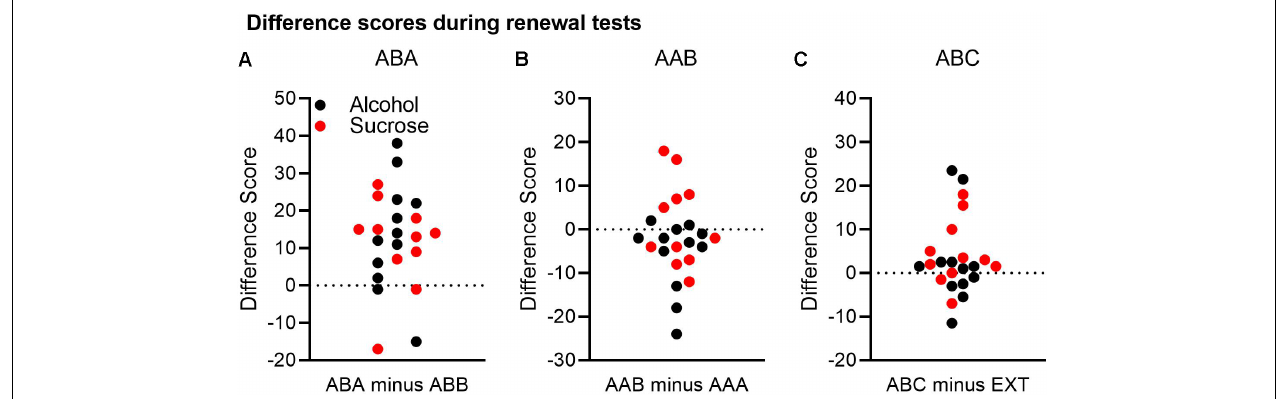
FIGURE 3 | A comparison of renewal across both the alcohol and sucrose studies. A difference score was calculated for each renewal experiment by subtracting (cid:49) CS port entries in the control context from (cid:49) CS port entries in the renewal context. In this analysis, a positive difference score would support a renewal effect. (A) In the ABA renewal experiment, 19 of 23 rats had positive difference scores. (B) In the AAB experiment, 6 of 23 rats had positive difference scores, and 16 rats had negative difference scores. (C) In the ABC renewal experiment, 15 of 23 rats had positive difference scores, and 7 had negative differences scores.